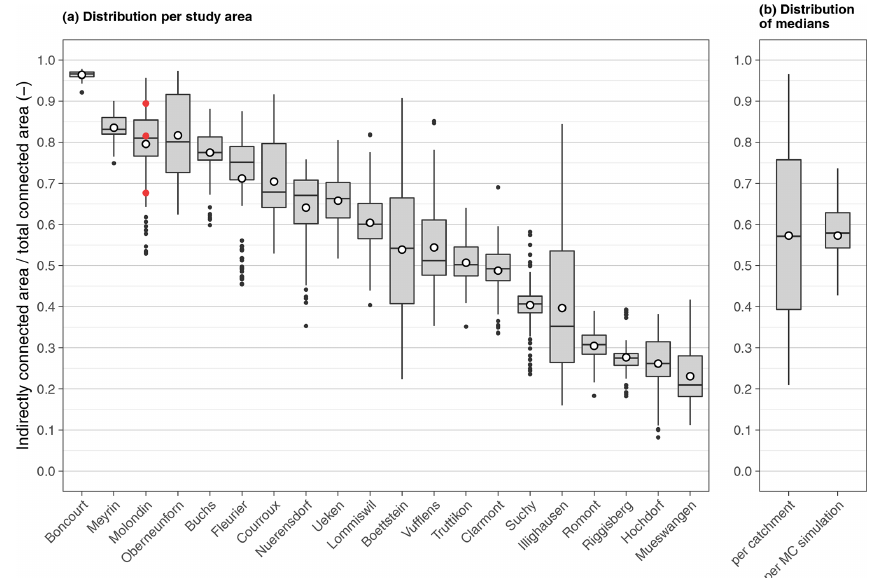
Figure 6. (a) Fractions of indirectly connected areas per total connected areas as calculated by the Monte Carlo analysis for each study area. White dots indicate the means of the distributions. The red dots indicate the results of the example Monte Carlo simulations (MC28, MC41, and MC 40) shown in Fig. 5. (b) Distribution of medians of fractions of indirectly connected areas per total connected areas per study catchment and per Monte Carlo